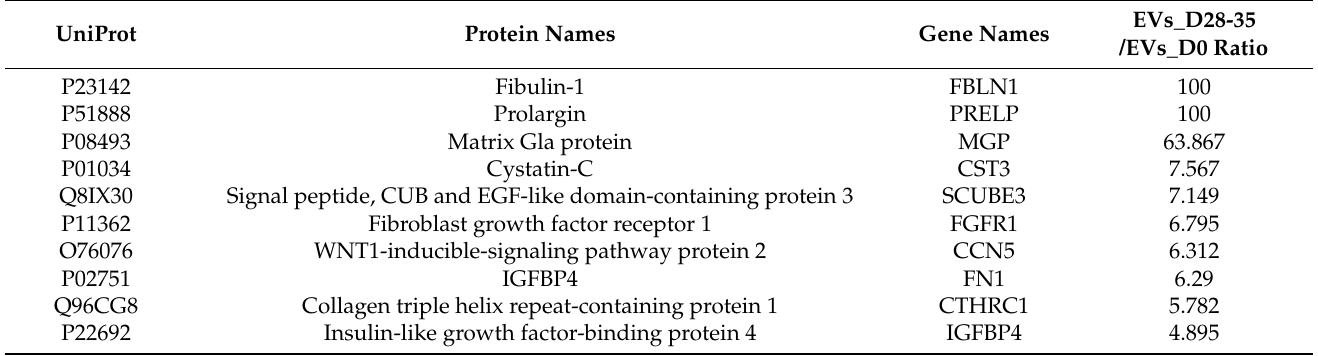
Figure 7. Venn diagram of total proteins and heatmap of significantly different proteins. ( A ) Venn diagram showing the distinct profiles of total proteins in the EVs_D28-35 and EVs_D0; n = 3. ( B ) Heatmap showing the distinct significant protein profiles of the EVs_D28-35 compared to EVs_D0; n = 3. Table 2. The expression/level ratio of selected pro-osteogenic proteins in EVs_D28-35 compared with that in